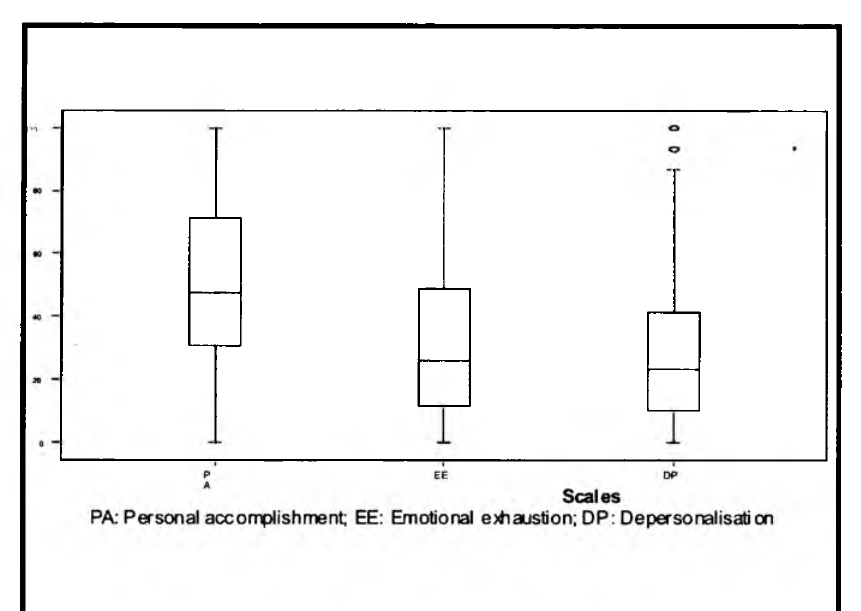
Figure 1: Scores on Maslach Burnout Inventory scales in